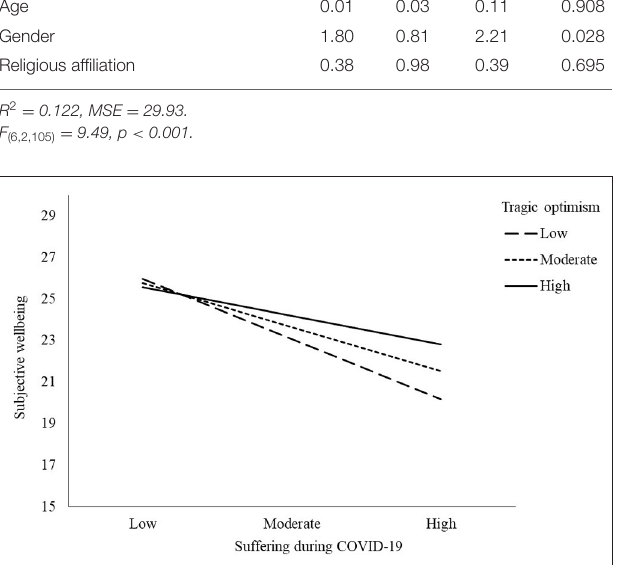
FIGURE 2 | Moderating effect of tragic